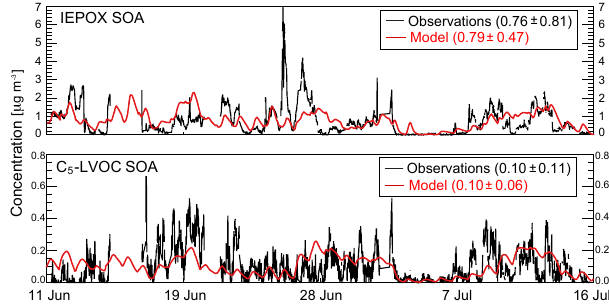
Figure 4. Time series of the concentrations of isoprene SOA components at the SOAS site in Centreville, Alabama (32.94 ◦ N; 87.18 ◦ W), in June–July 2013: measured (black) and modeled (red) IEPOX SOA (top) and C 5 -LVOC SOA (bottom) mass concentra- tions. Means and 1 σ standard deviations are given for the observa- tions and the